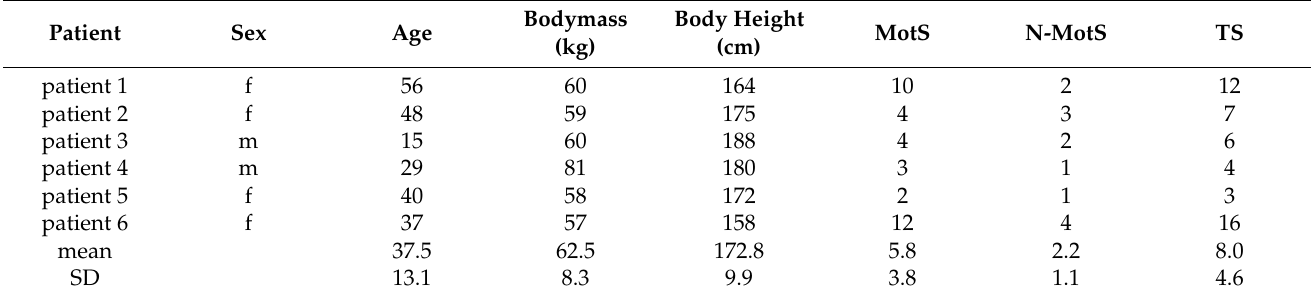
Individual data of the six patients without two clearly distinguishable peaks in their